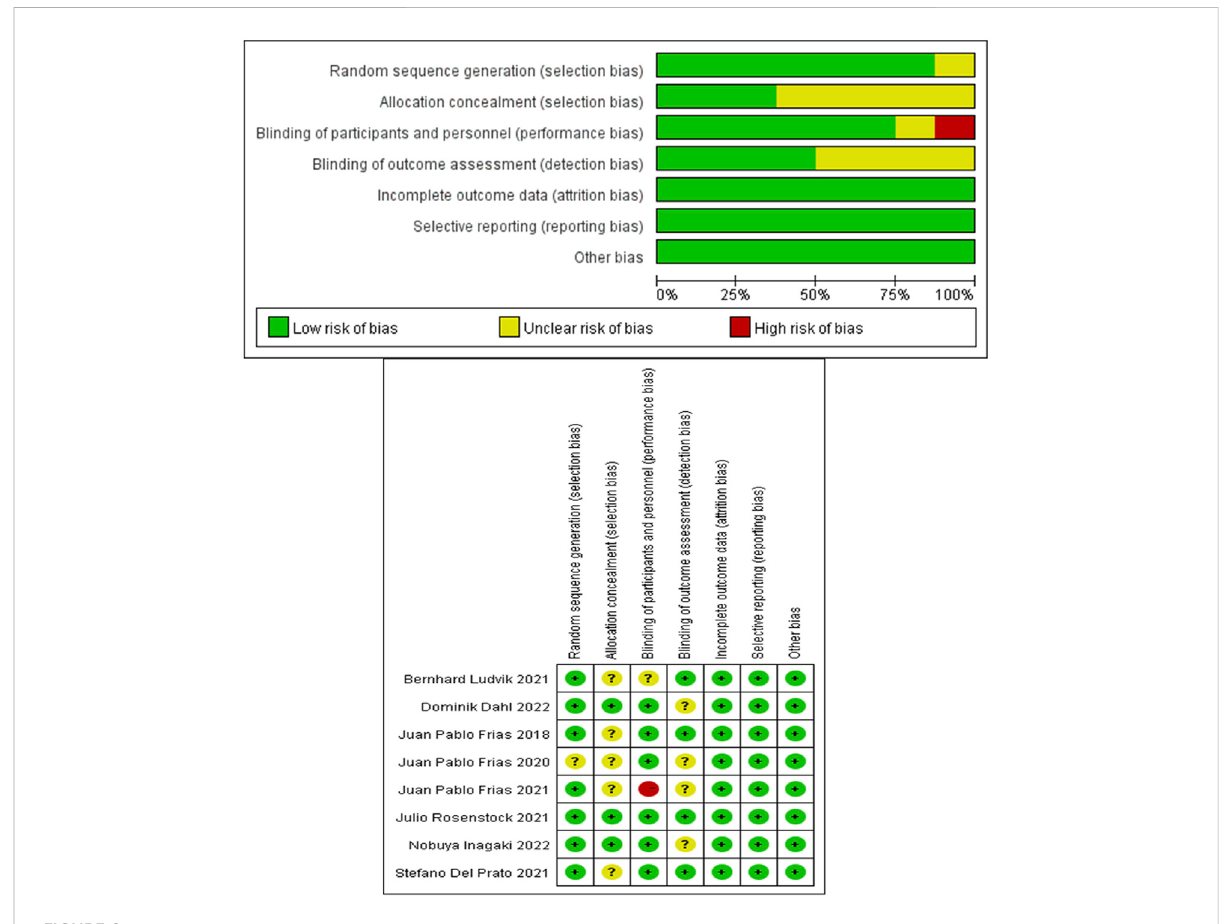
FIGURE 2 Assessment of the risk of bias in included